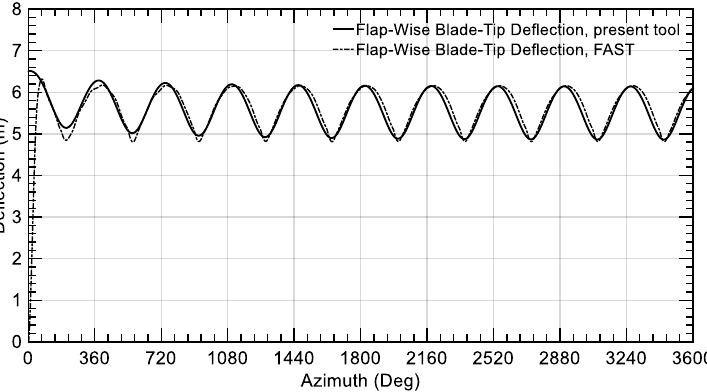
Figure 12. Blade-tip, flap-wise deflection.